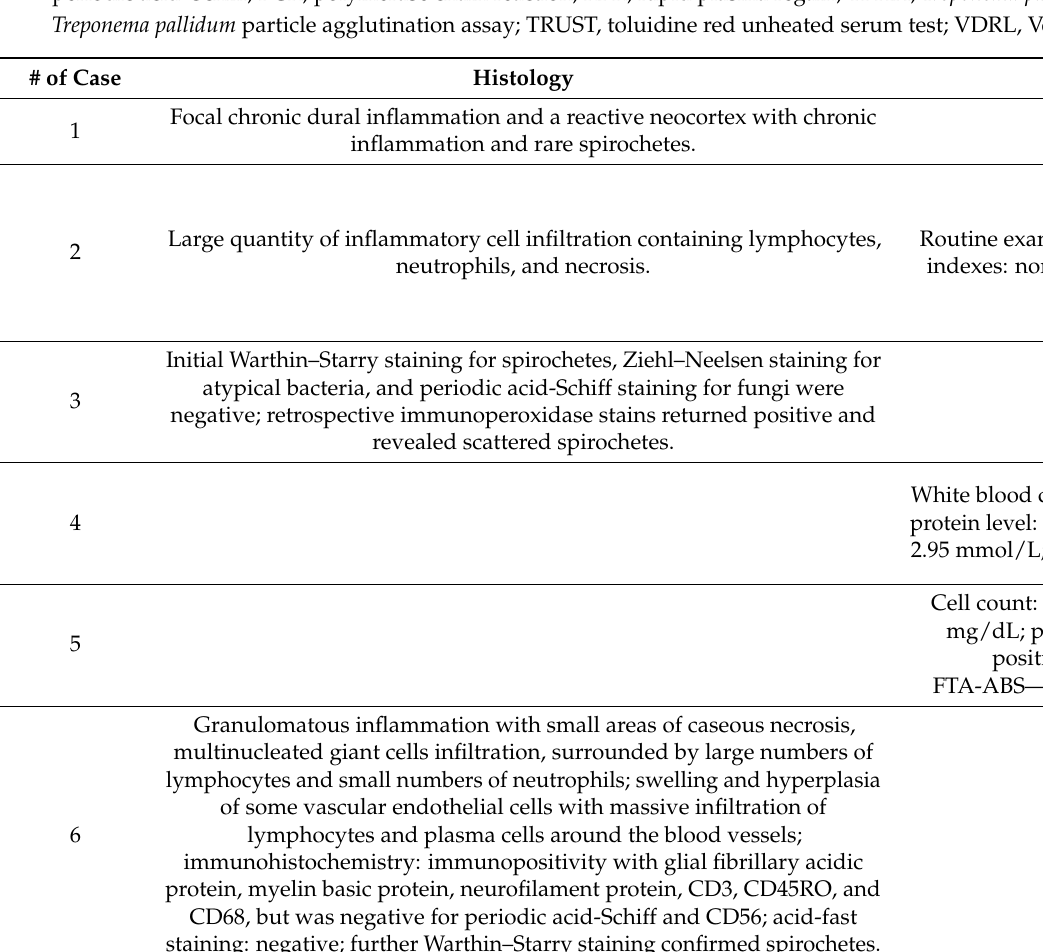
Table 3. Listed are all identified cases between the years 1990 and 2021. Ordered by years of the report (as in Table 1). Shown are the histological, CSF, and neuroimaging findings. (Abbreviations: CD, cluster of differentiation; CSF, cerebrospinal fluid; CT, computed tomography; DNA, deoxyribonucleic acid; DWI, diffusion-weighted magnetic resonance imaging; FLAIR, fluid-attenuated inversion recovery; FTA-ABS, fluorescent treponemal antibody absorption; GFAP, glial fibrillary acidic protein; HE, hematoxylin and eosin; HHV, human herpesvirus; IgG, immunoglobulin G; MRI, magnetic resonance imaging; SPECT, single-photon emission computed tomography; MBP, mannose-binding lectin; NF, neurofilament; PAS, periodic acid–Schiff; PCR, polymerase chain reaction; RPR, rapid plasma regain; TPHA, Treponema pallidum hemagglutination assay; TPLA, Treponema pallidum latex agglutination;